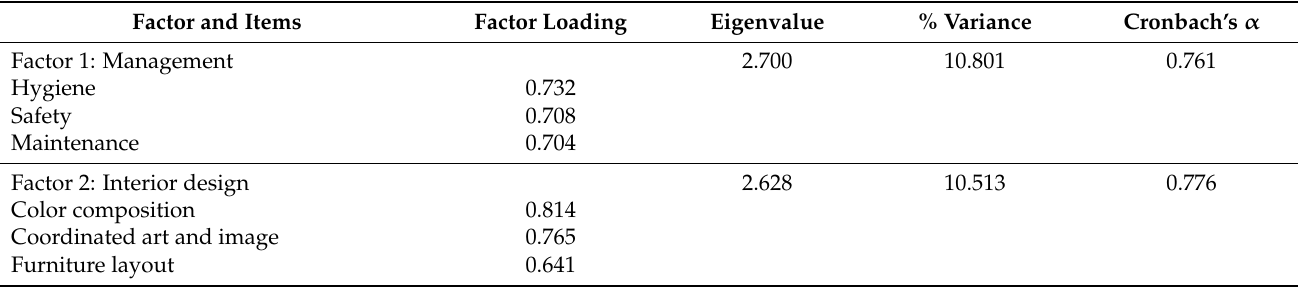
Table 3. Principle component analysis and varimax rotation of the important therapeutic environ- mental criteria (factors and